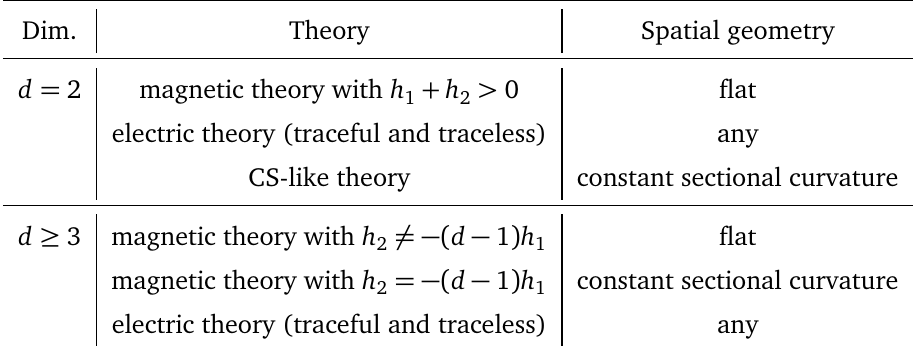
= − ( d − 1 ) h , only has a non- 2 1